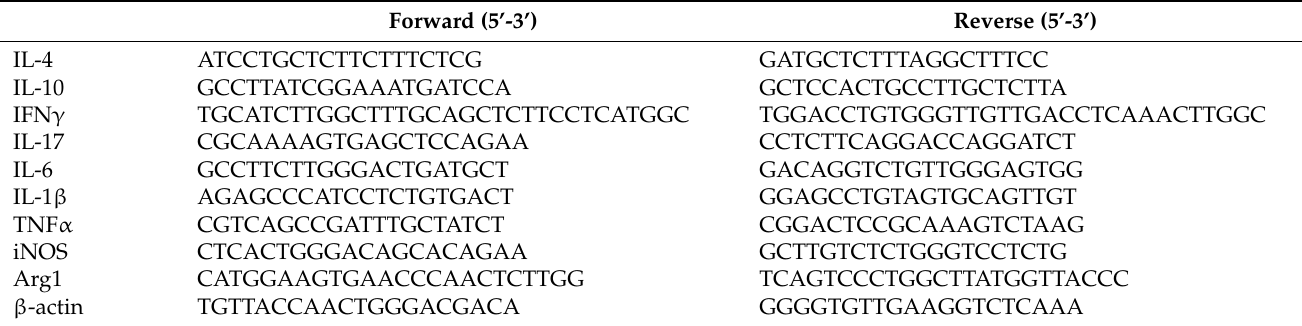
Table 1. Sequences of the primer sets used for real time